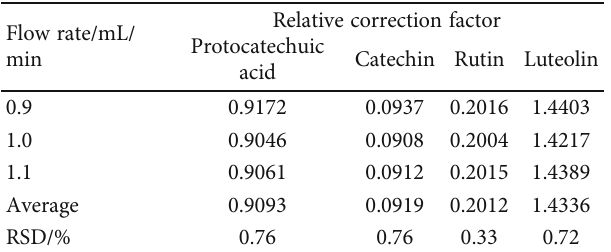
Table 7: E ff ects of di ff erent volume fl ow rates on relative correction